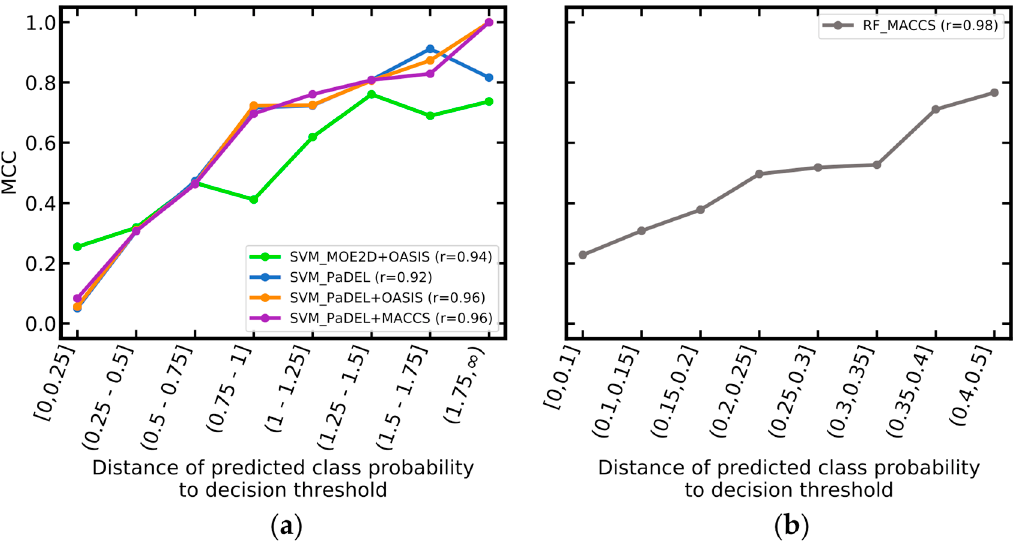
Figure 8. Matthews correlation coefficient (MCC) as a function of the distance between the predicted class probabilities and the decision thresholds, for the ( a ) support vector machine (SVM) models and ( b ) random forest (RF) model. The number of compounds in each bin is summarized in Table S8.